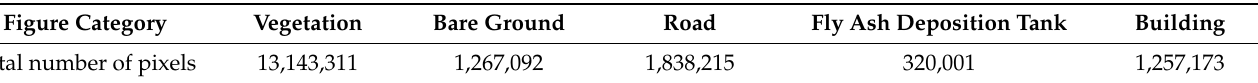
Table 2. Figure category pixel count in 2010. Figure Category